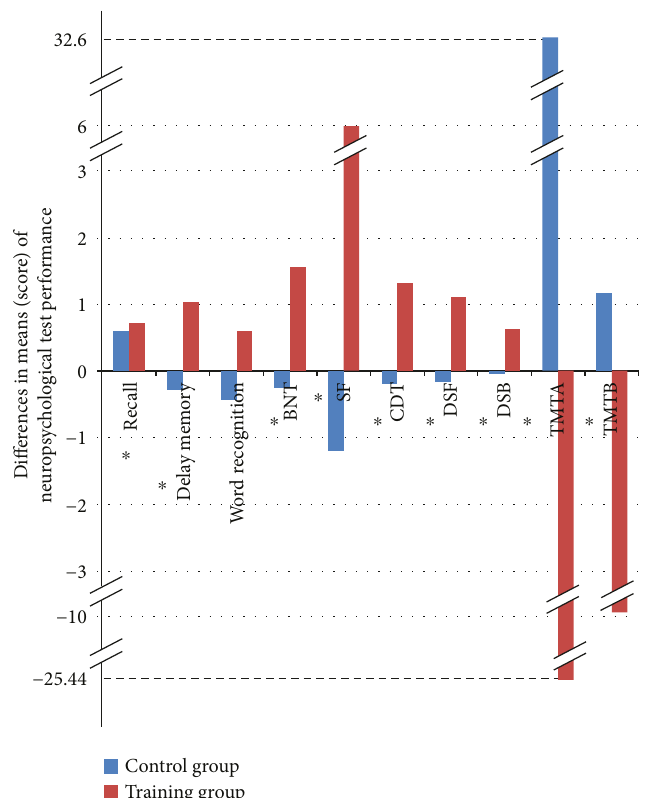
Figure 2: Comparison of the mean di ff erence (score) of the two assessments (baseline minus endpoint in each group) between the two groups (training group versus controls). Recall; delayed memory; word recognition; BNT: Boston Naming Test; SF: semantic fl uency; CDT: clock- drawing test; DSF: digit span forward; DSB: digit span backward; TMT A: trail-making test A; TMT B: trail-making test B. ∗ Statistical signi fi cant values ( p < 0 05